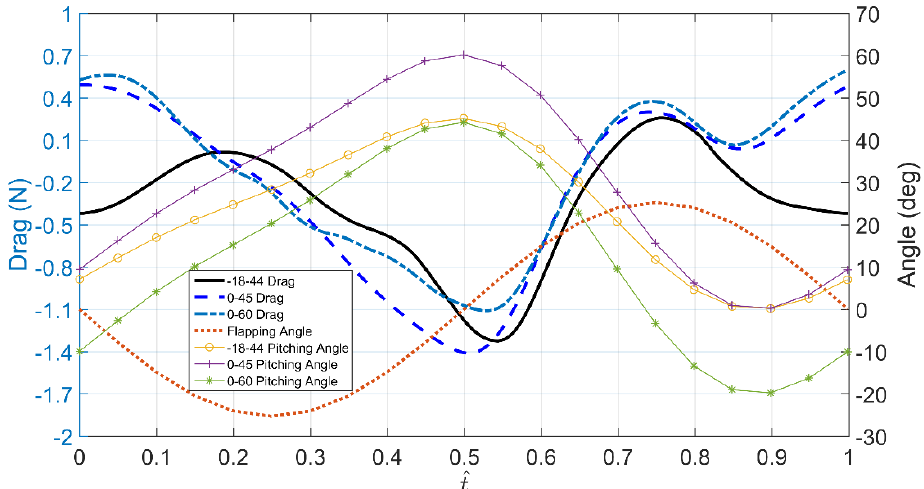
Figure 16. The drag forces of the flapping wing in three cases of pitching angle variation.